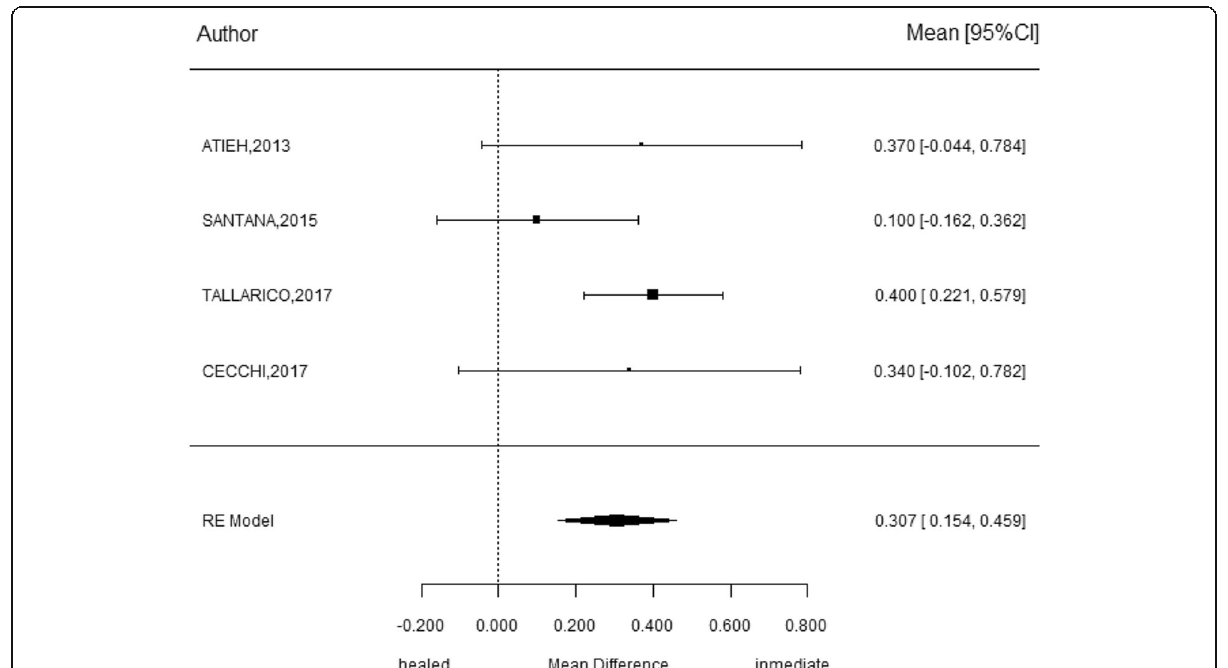
Fig. 8 Meta-analysis of marginal bone loss between immediate and conventional